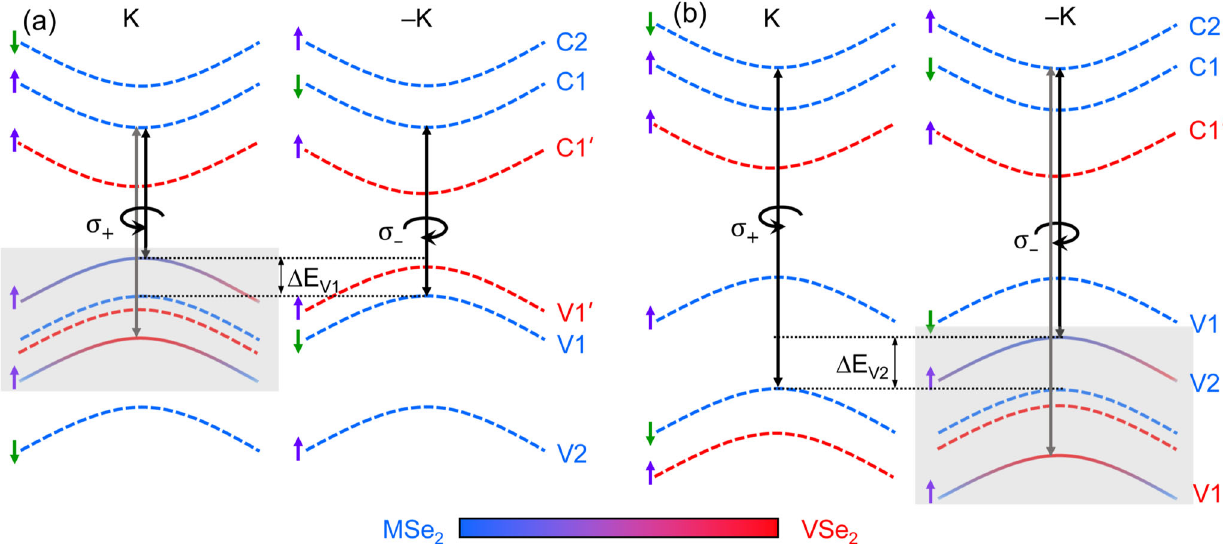
Fig. 2 Schematic diagrams of two scenarios of interlayer hybridization. The energy levels for MSe 2 and VSe 2 before hybridization are shown by blue and red dashed lines, while hybridization between valence bands from MSe 2 and VSe 2 with aligned spin, lead to the hybridized bands indicated by colored solid lines. Two different scenarios are highlighted by the shadowed boxes. The corresponding band labels are shown to the right, with Vn/Cn (Vn ′ /Cn ′ ) denoting valence/conduction bands for MSe 2 (VSe 2 ). Δ E V1 and Δ E V2 are the valley bands splitting of the topmost valence band (V1) and second topmost valence band (V2) for MSe 2 . The short arrows alongside the bands represent spin direction. The resulting circularly polarized valley-split A and B excitonic transitions are also